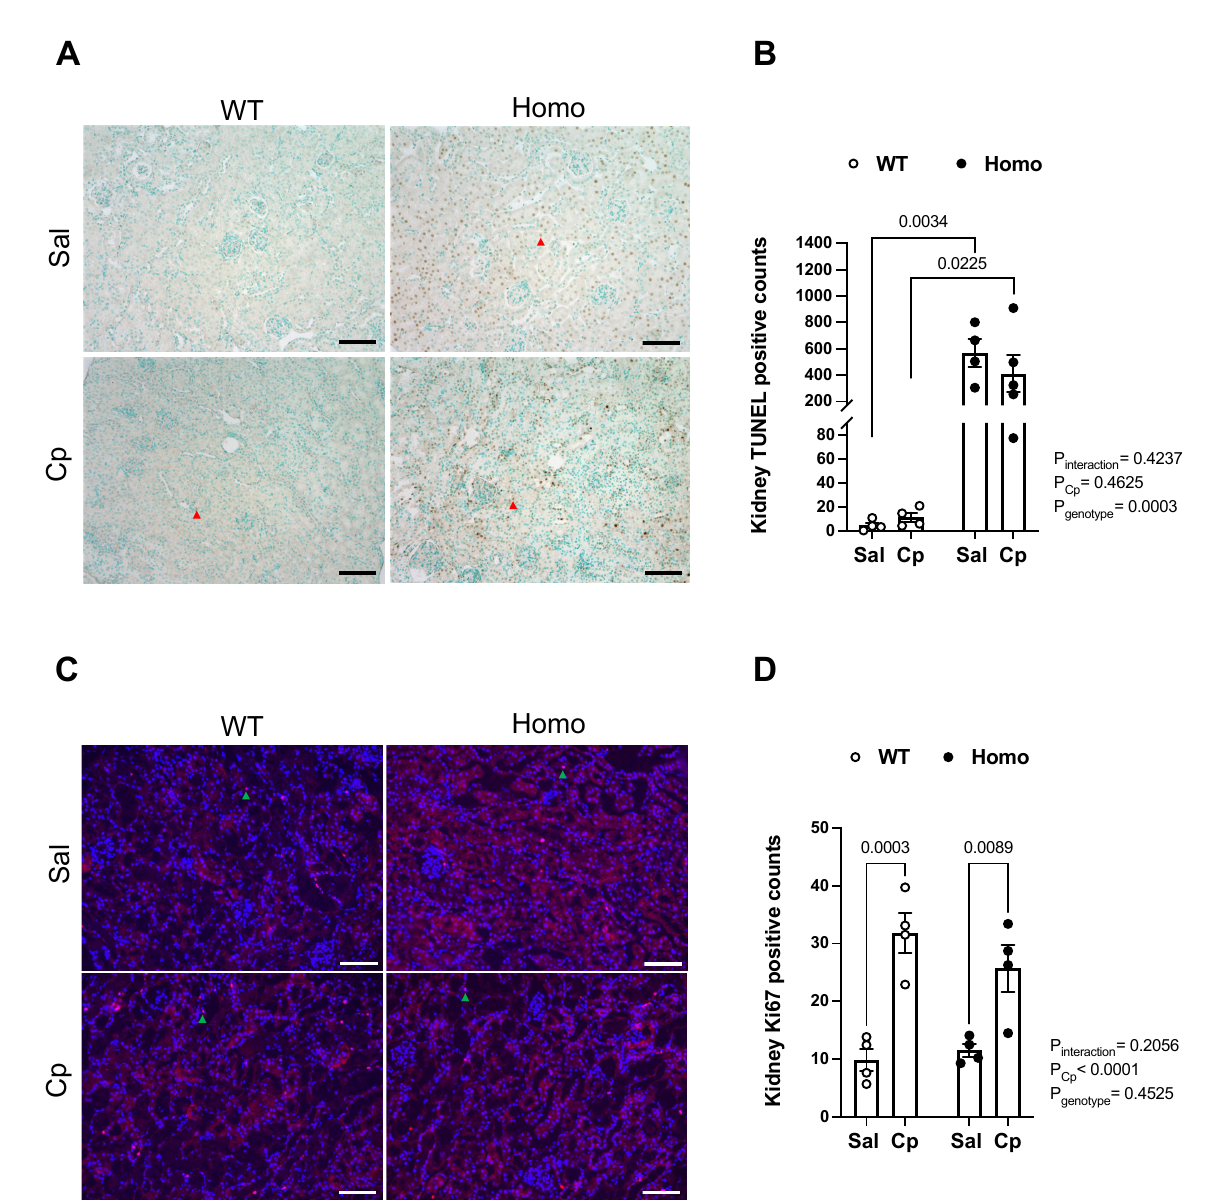
Figure 6. Effect of GPER1 deletion on cell death and proliferation in cisplatin-treated mice. Rep- resentative images for TUNEL assay performed for kidney sections obtained from cisplatin (Cp, 20 mg/kg) or saline-treated male mice, homozygous (homo) knockout for GPER1 gene, and wild-type (WT) littermates on day 3 of the treatment are demonstrated ( A ). Red arrowheads point to TUNEL-positive nuclei. Quantification of TUNEL-positive nuclei in different experimental groups is demonstrated ( B ). Representative images for Ki67 immunostaining performed for kidney sec- tions obtained from cisplatin (Cp, 20 mg/kg) or saline-treated homo and WT male mice on day 3 of the treatment are demonstrated ( C ). Green arrowheads point to TUNEL-positive nuclei. Scale bar represents 200 µ m. Quantification of Ki67-positive nuclei in different experimental groups is demonstrated ( D ). Data are presented as mean ± SEM (n = 4–5 mice/group). Statistical comparisons were performed by two-way ANOVA with Sidak’s post hoc test for multiple comparisons. p values for ANOVA and post hoc test results are displayed on the figure. Cp, cisplatin; Homo, homozygous knockout for GPER1 gene; Sal, saline; TUNEL, Terminal deoxynucleotidyl transferase-mediated dUTP nick-end labeling; WT,